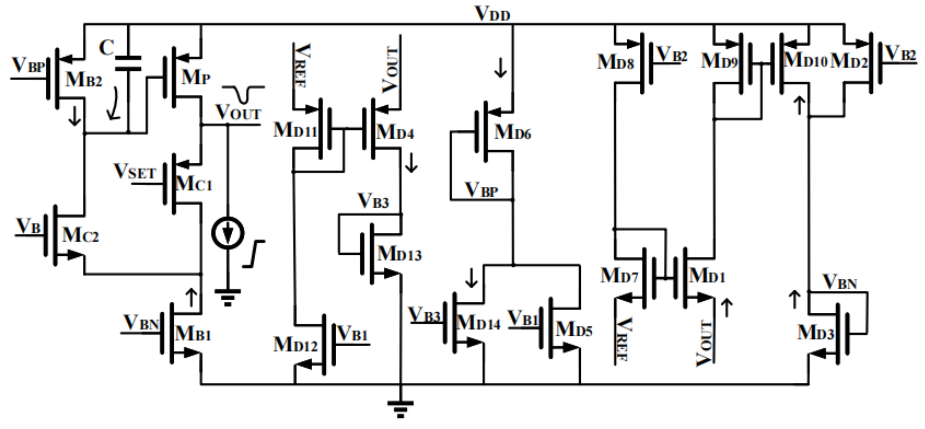
Figure 6. Signal response when I OUT